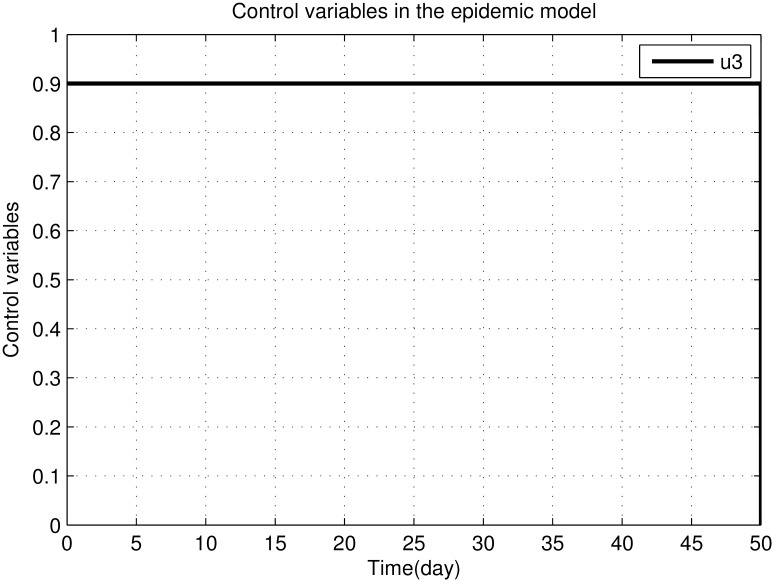
The graph shows the control variable u3.